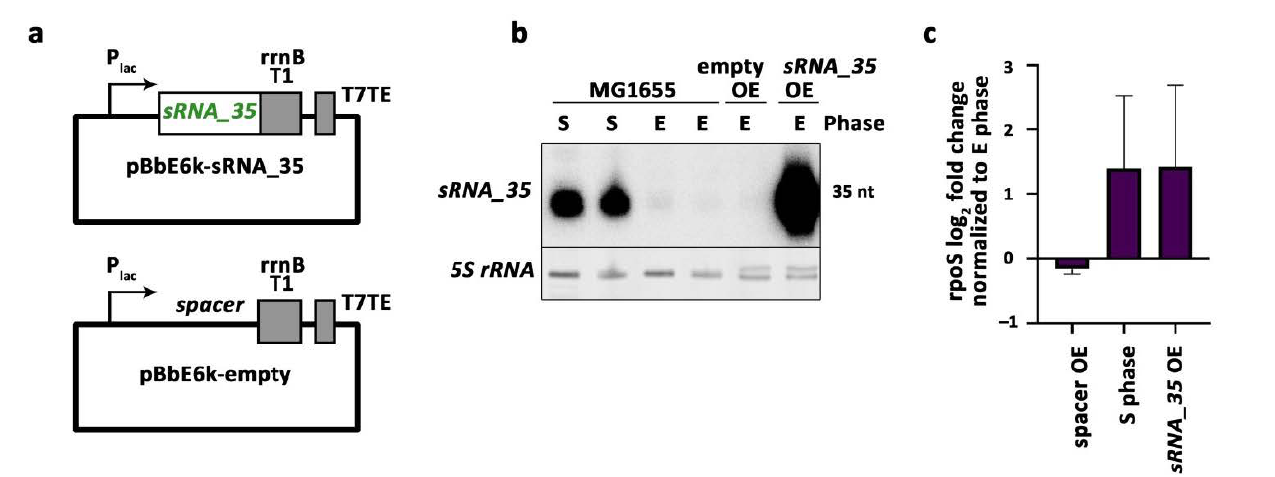
Figure 5. Overexpression of sRNA_35 upregulates rpoS expression. ( a ) Schematic representation of constructed plasmids for sRNA_35 (top) and control (bottom) overexpression. P lac = lac operon promoter, inducible by IPTG. rrnB T1 and T7TE are terminator sequences. ( b ) Northern blot analysis of sRNA_35 (intergenic sRNA). E = exponential phase, S = stationary phase, OE = overexpression. Predicted sizes are displayed on the right in nt (nucleotides). ( c ) RT-qPCR mean and SEM for rpoS expression under different conditions (two biological replicates each). E = exponential phase, S = stationary phase, OE = overexpression. log 2 fold change is reported for all conditions in comparison to exponential phase